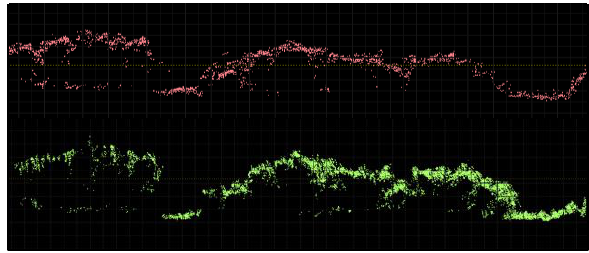
Figure 4. Profile views of LiDAR data over the same densely vegetated area in 2017 (top) and 2018 (bottom).